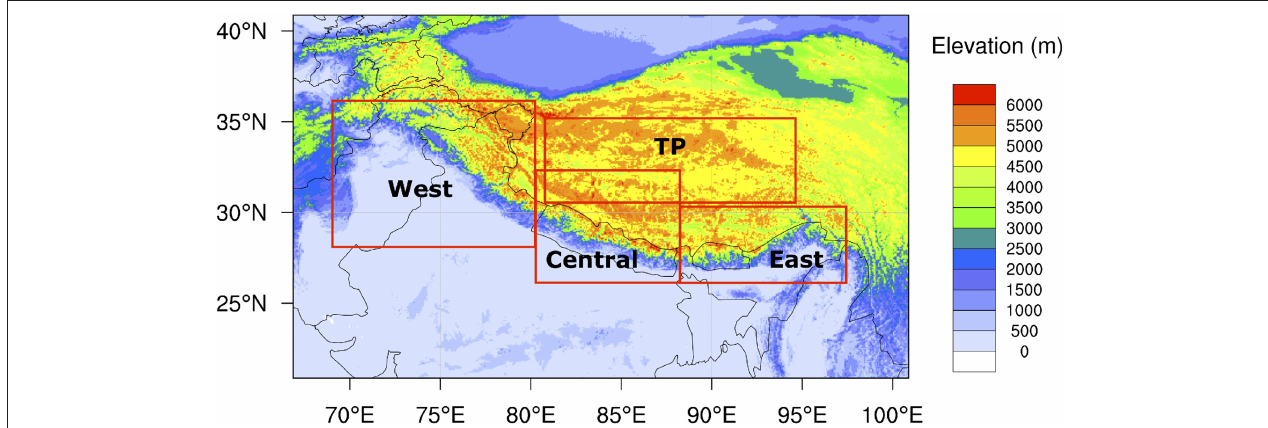
FIGURE 1 | The High Mountain Asia (HMA) domain and the corresponding sub-regions with the terrain elevation as the background. Note that TP is the Tibetan Plateau.